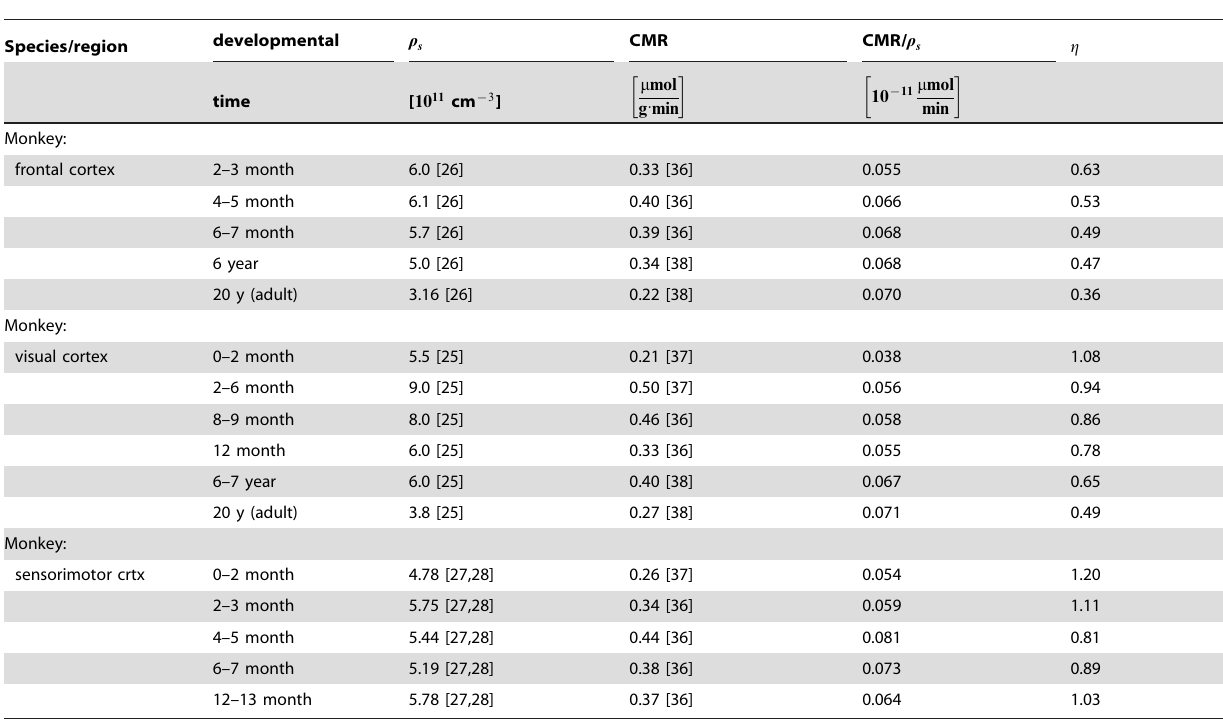
Table 2. Synaptic and metabolic development for monkey cerebral cortex.